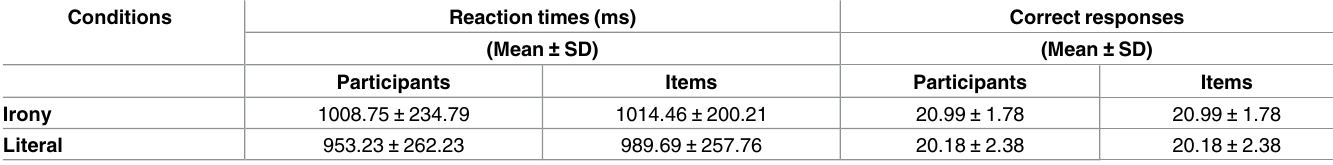
Table 2. Behavioral data per participants and per